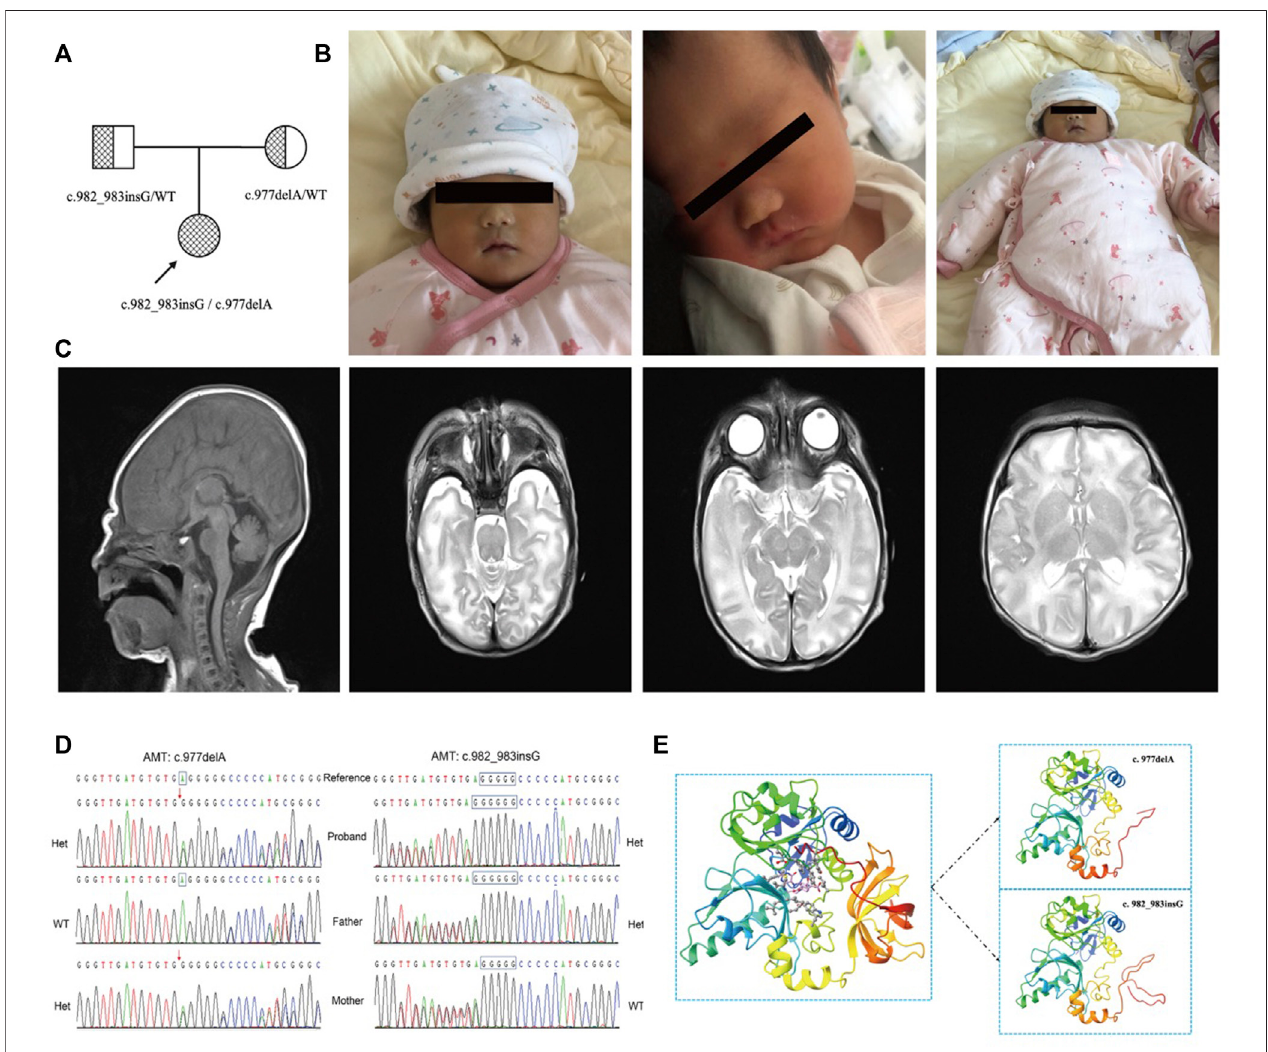
FIGURE1|(A) Thepedigreeofthefamily.Theprobandisacompoundheterozygousmutationinthe AMT gene.Bothoftheirparentsarecarriers. (B) .Theimageof the proband at birth. The complexion is ruddy, the reaction isgood, theconsciousness isclear, and theappearance is not obviously abnormal. (C) . The brain MRI ofthe proband. It shows that the hind limbs of the bilateral internal capsule, the midbrain, and the pons show symmetrical cytotoxic edema, and the bilateral globus pallidus in the T1WI sequence presents an increasing signal. (D) . The veri fi cation result of Sanger sequencing. The proband is a compound heterozygous variation with (C) 977delAand (C) 982_983insGofthe AMT gene.Thevariant (C) 977delAisfromthemother. (C) 982_983insGisfromthefather.Hetisheterogenous,WTiswildtype. (E) 3D image of AMT protein. The left of the fi gure is the 3D overall picture of wildtype (WT) AMT protein, the upper part of the right fi gure is the 3D overall picture of p.Glu326Glyfs*12 mutant (MUT) AMT protein, and the lower part of the right fi gure is the 3D overall picture of p.Ala328Glyfs*22 mutant (MUT) AMT protein.